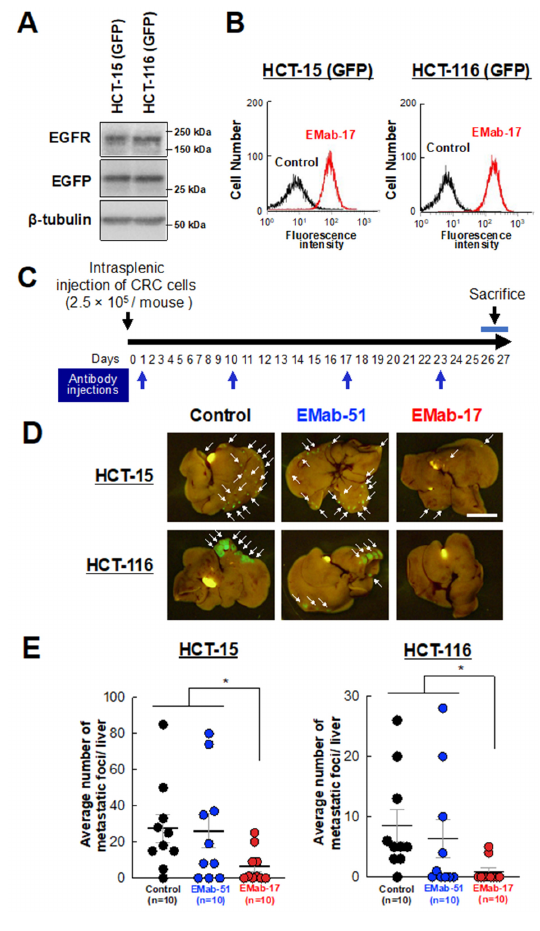
Figure 6. Anti-metastatic effects of an anti-EGFR antibody EMab-17 on CRC metastasis to the liver. ( A ) HCT-15-GFP and cloned GFP-labeled HCT-116 (HCT-116-GFP) cells were subjected to Western blotting analysis with an anti-EGFR, anti-GFP or anti- β -tubulin antibody. ( B ) Flow cytometry using the anti-EGFR antibody EMab-17 for HCT-15-GFP or HCT-116-GFP cells. ( C ) Experimental schedule. HCT-15-GFP and HCT-116-GFP cells (2.5 × 10 5 cells suspended with Matrigel/10 μ L) were injected into the spleens. The antibodies (100 μ g/mouse) were intraperitoneally administered 1, 10, 17 and 23 days after the inoculation of cancer cells. The mice were sacrificed 26 or 27 days after the injection of cancer cells, and the livers were removed to determine the number of metastatic CRC cells. ( D ) Representative images of the liver. The arrows point to the site of metastasis. Scale bar: 1 cm. ( E ) Number of metastatic tumors in the liver. The mean number for each group is expressed with a horizontal bar; 10 mice were used per group. The values are presented as means ± SEM. *: p < 0.05 vs. control and EMab-51-treated groups.